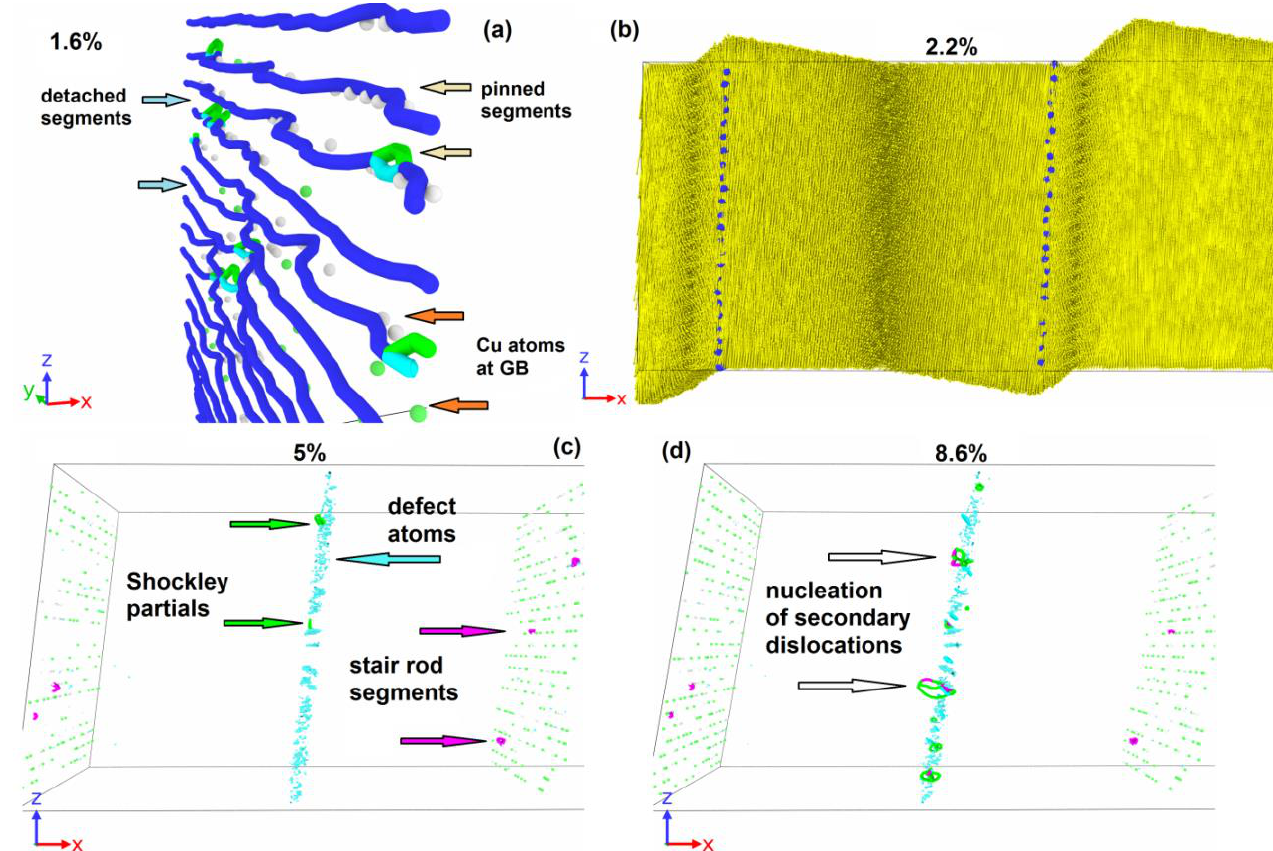
Figure 6. Deformation of system with 15% filling of one column by Cu atoms (0.81 nm − 2 ) in each pentagonal void at GBs. ( a ) GB representing dislocation wall pinned at Cu atoms (white and green circles). ( b ) Displacement vectors of atoms (yellow) and dislocation walls. Dislocation walls slip to each other. ( c ) Place of dislocation wall annihilation. Light-blue points are defect atom clusters; green points are Cu atoms in the original places of GBs. ( d ) Nucleation of secondary dislocations from defect atom clusters. Dislocation structure is determined by DXA: blue lines are perfect dislocations, green—Shockley partials, light blue—Frank partials, purple—stair rod segments.